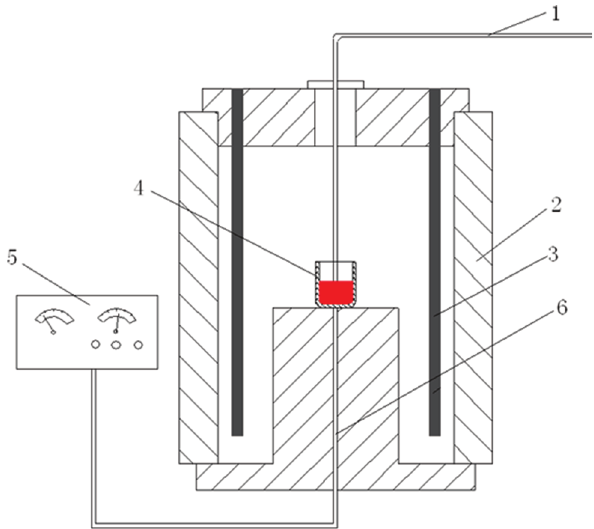
Figure 1: Experimental apparatus of elevated temperature experi- ments. Note: 1, quartz tube; 2, refractory bricks; 3, MoSi 2 heating elements; 4, crucible; 5, temperature controller; 6,